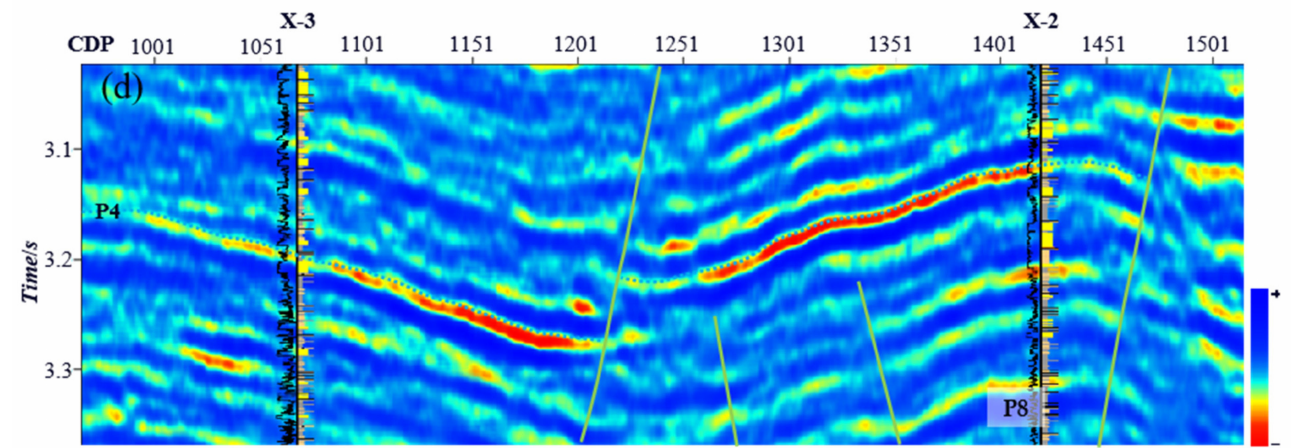
Figure 9. Post-stack and partial stacked seismic profiles across Wells X-2 and X-3. For locations of the profiles, see Figure 1. ( a ) The post-stack seismic profile; ( b ) the near offset partial stacked seismic profile; ( c ) the far-offset partial stacked seismic profile; ( d ) P + G hydrocarbon detection